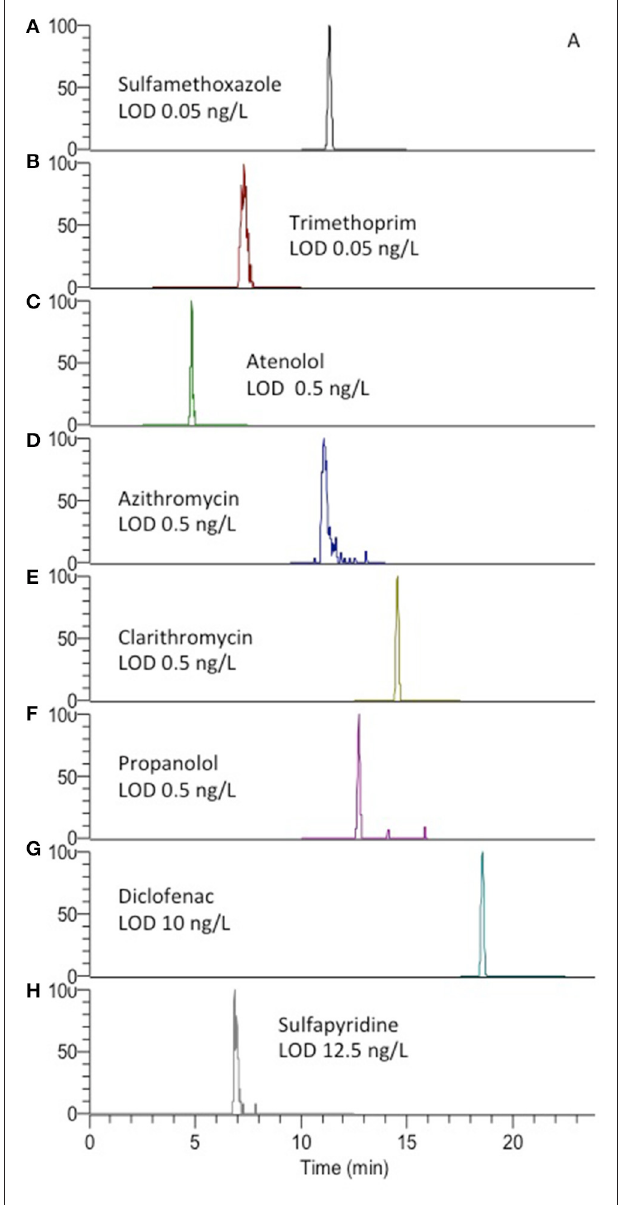
FIGURE 3 | Extracted ion chromatograms (EICC) of (A) sulfamethoxazole, (B) trimethoprime, (C) atenolol, (D) azithromycin, (E) clarithromycin, (F) propanolol, (G) diclofenac, and (H) sulfapyridine using the described AFFL-SPE-LC-MS system. MS/MS transition details are presented in Table S1.